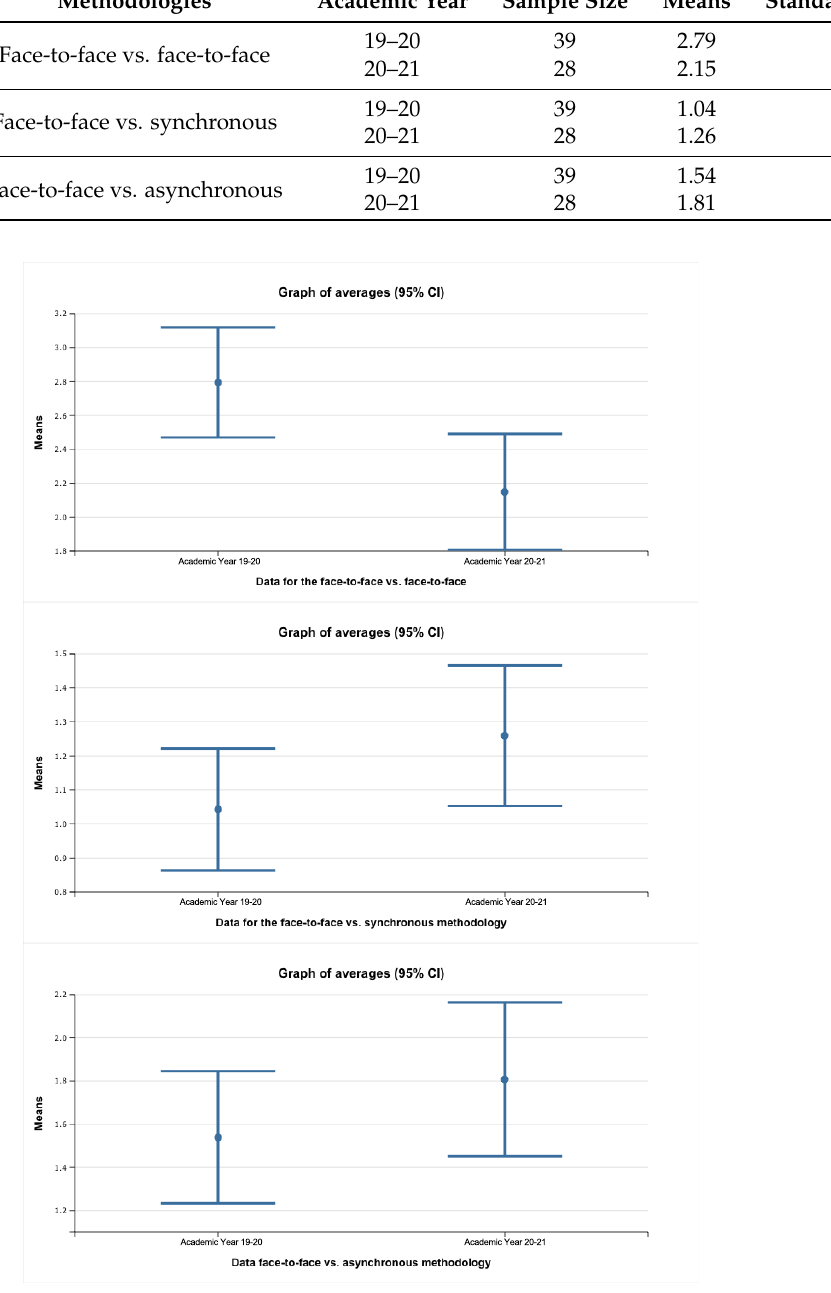
Figure 3. Comparison of